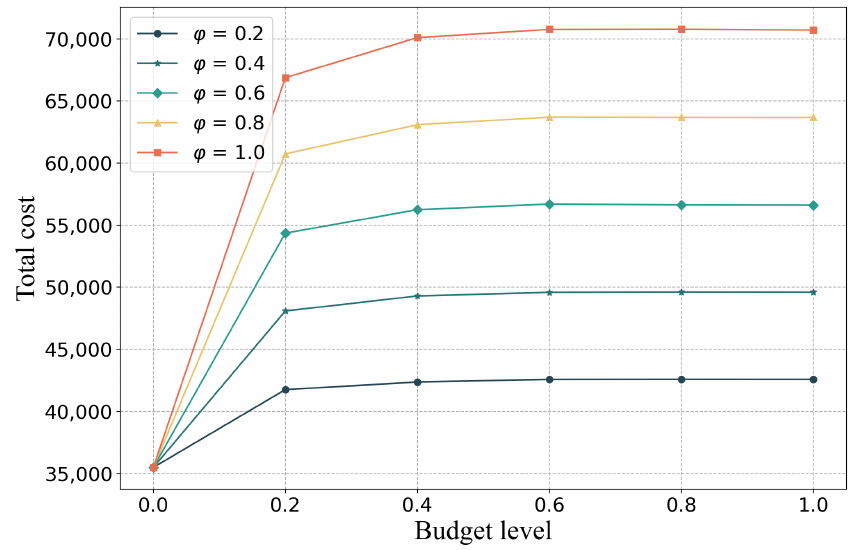
Figure 2. Impact of uncertain budget level and deviation level on the total cost.